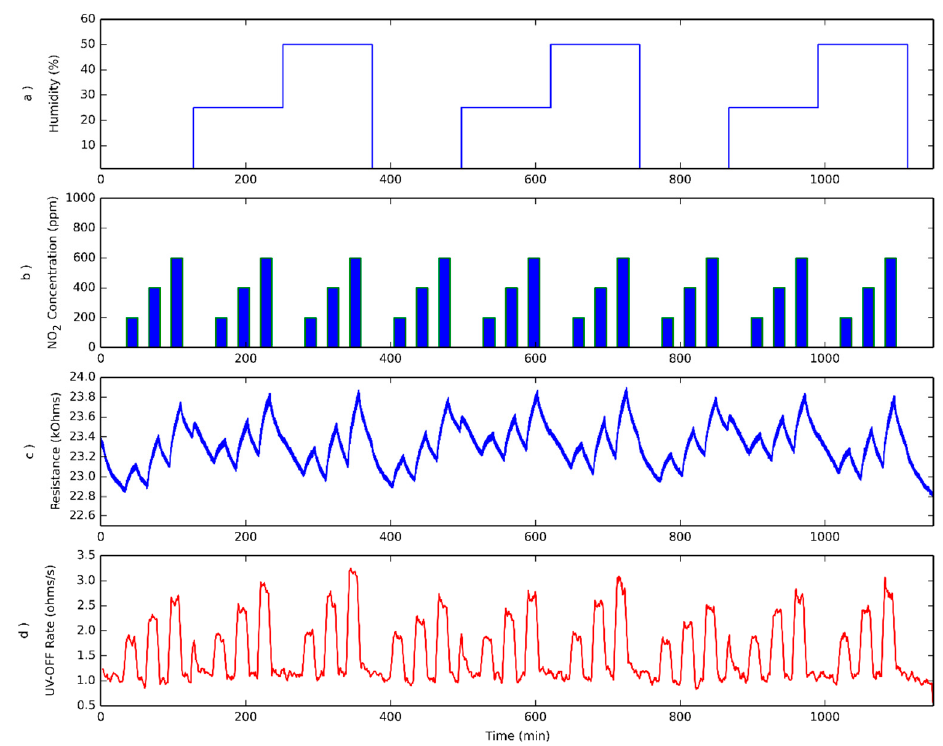
Figure 8. Effect of varying moisture levels on sensor response. The sensor has been characterized at three different humidity levels while operating at 50 °C ( a ), and at three different NO 2 concentrations ( b ). Evolution of sensor resistance under pulsed UV light for the different humidity levels and NO 2 concentrations shown in upper panels ( c ). Rate of resistance change evaluated when UV light is OFF, as defined in Equation (1), while the sensor is operated at 50 °C ( d ).